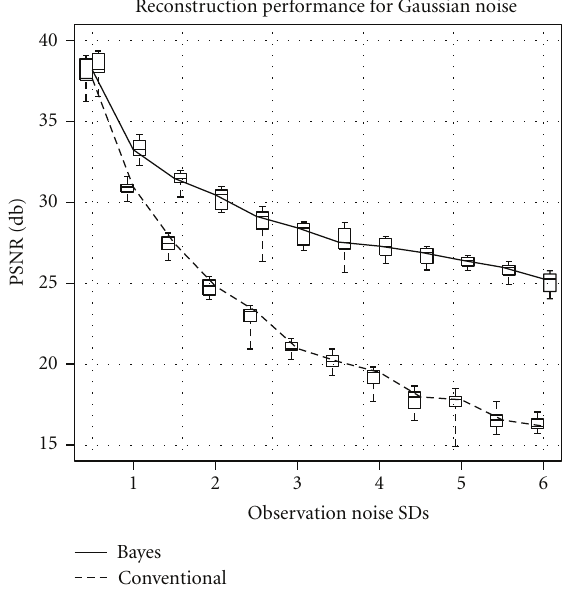
Figure 3: Qualities of reconstruction images measured by PSNR. The horizontal axis shows the SD of the Gaussian noise. The vertical axis shows the PSNR. The solid line shows the median of the 10 trials of our Bayesian inference results, and box plot shows quartile deviation. The dashed line shows the results of the conventional FBP method.